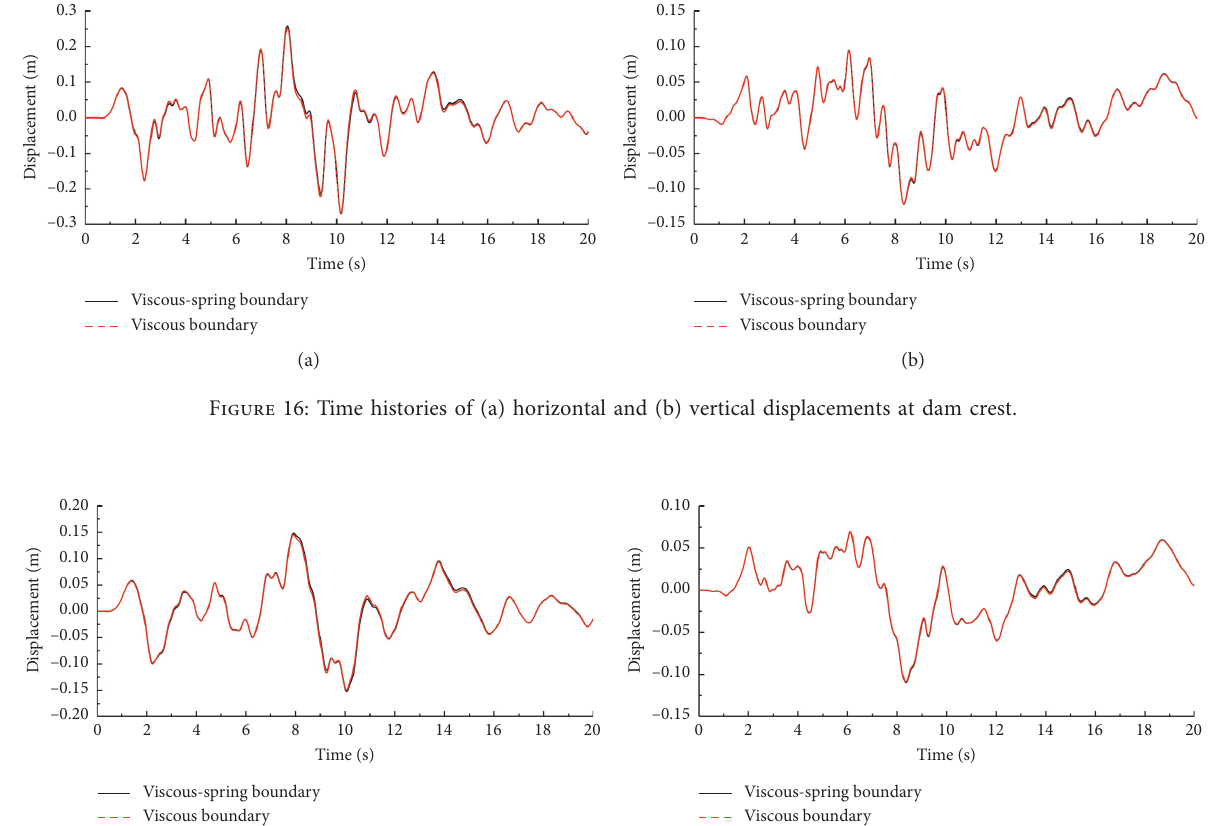
Time histories of the principal tensile stress at dam heel and principal compressive stress at dam toe are shown in Figure 21. For the solutions using the viscous- spring boundary and viscous boundary, the maximum principal tensile stresses at dam heel are 4.56 MPa and 4.76 MPa, and the minimum principal compressive stresses at dam toe are − 6.89 MPa and − 6.82 MPa,